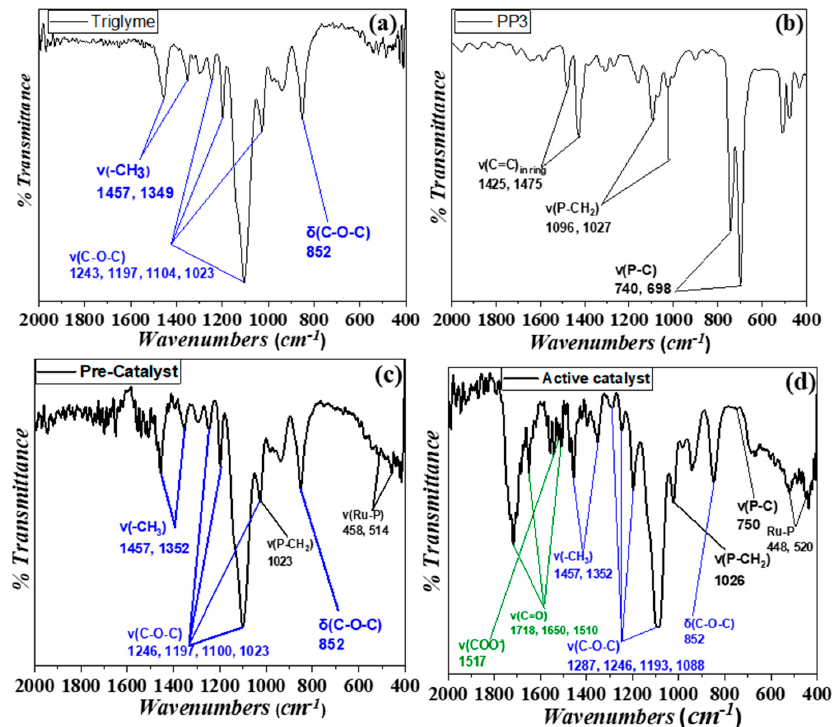
Figure 4 . ATR-FTIR spectra of ( a ) tri-glyme (solvent), ( b ) phosphine ligand (PP3), ( c ) [Ru/PP3] catalyst in tri-glyme and ( d ) catalytic reaction ((Ru/PP3)/FA/KOH in tri-glyme: water solution).